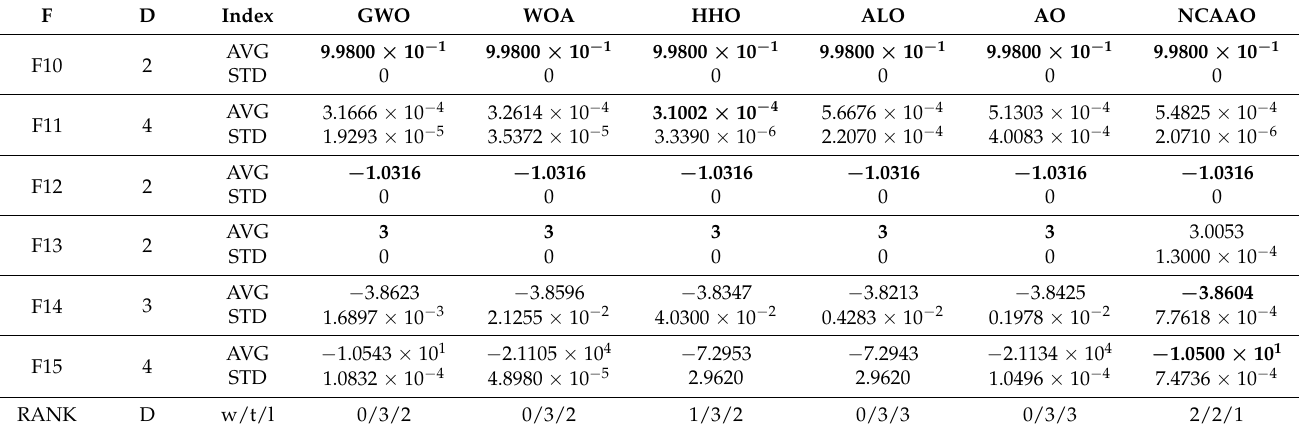
Table 7. The comparison of obtained solutions for fixed-dimension multimodal